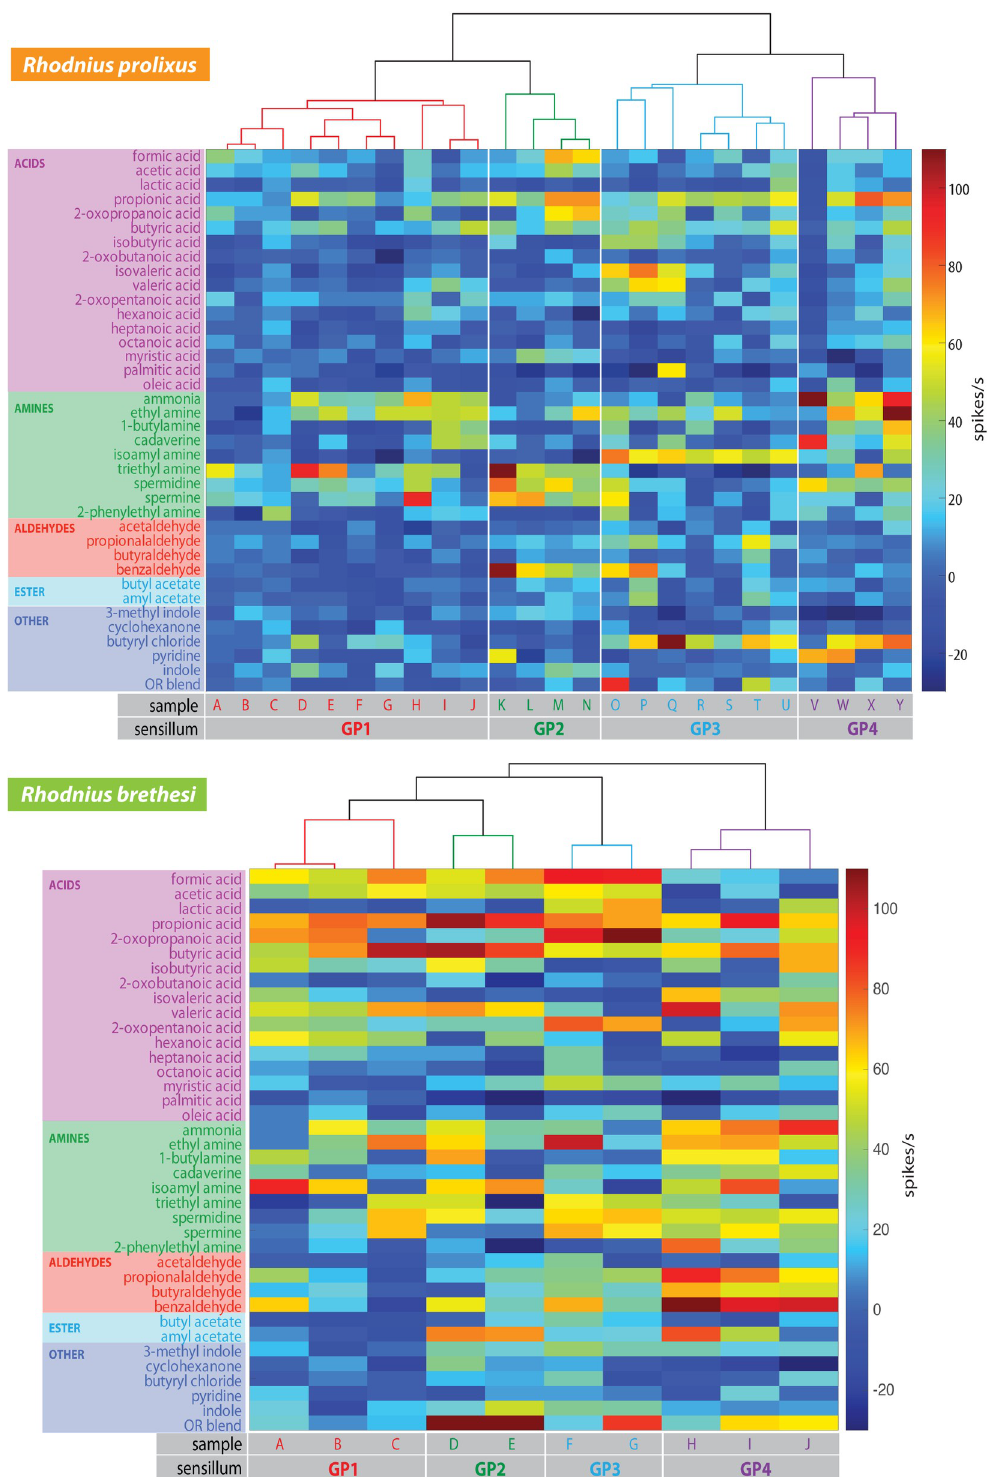
Fig 6. Functional classification of grooved peg sensilla in Rhodnius prolixus and Rhodnius brethesi . Color-coded responses from the grooved peg sensillum (flagellomere II) in R . prolixus (n = 25) and R . brethesi (n = 10) to the odor panel. In each case, the dendrogram represents the agglomerative hierarchical clustering (Ward’s method, Euclidean distance) of these responses.